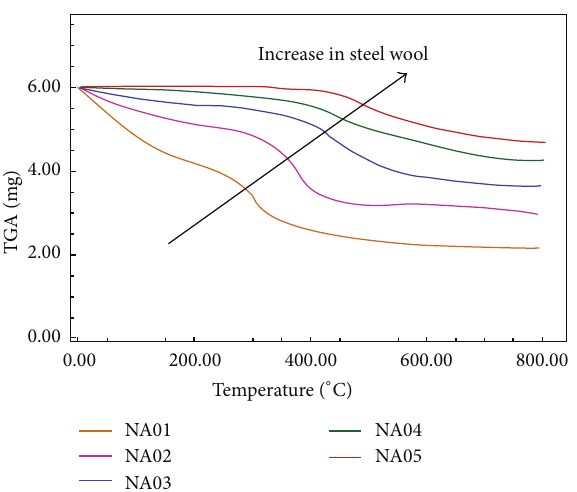
Figure 7: Thermogravimetric analysis (TGA) results of the devel- oped friction composites.